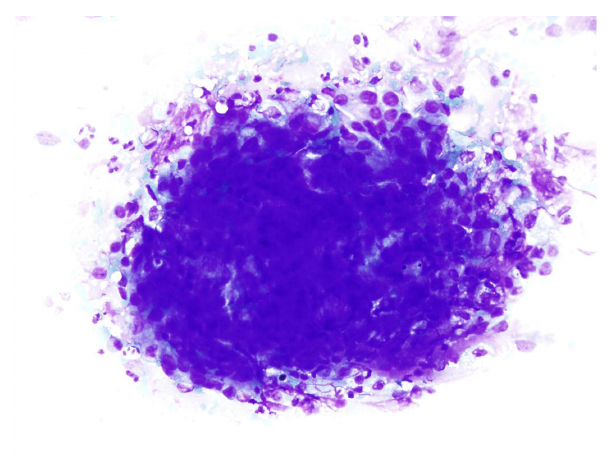
FIGURE 3 | Lung fine needle aspiration shows granulomatous reaction with epithelioid histiocytes, acute and chronic inflammation (Diff-Quik stain, 400 × ) .